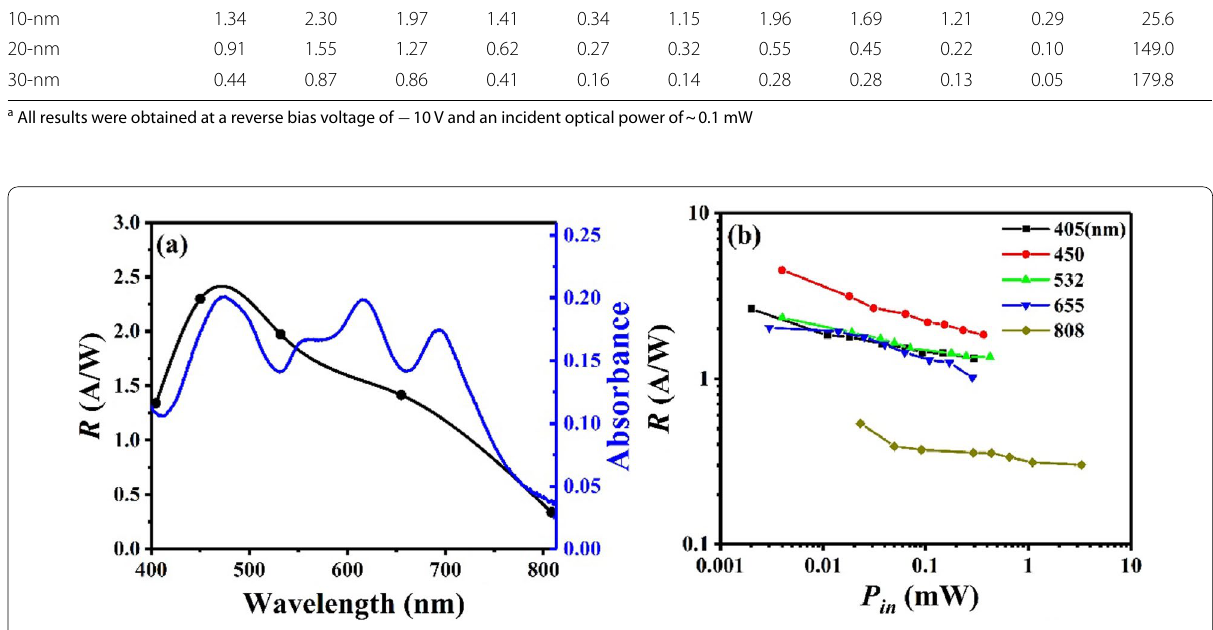
Fig. 8 a The dependence of photoresponsivity R on the wavelength. b The logarithmic dependences of R on the incident optical power P in . All results were obtained at a reverse bias voltage of 10 V and an incident optical power of ~ 0.1 −